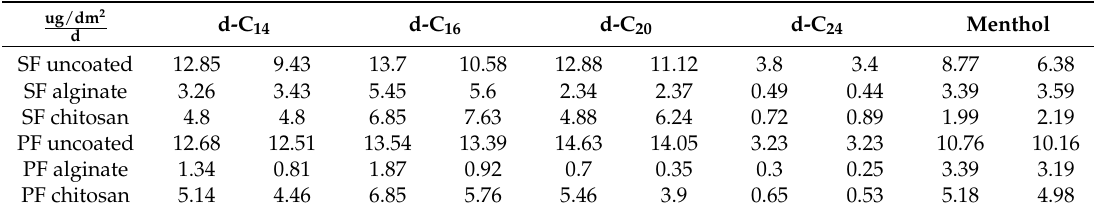
Table 6. Comparison of the permeation rates of deuterated n-alkanes of various chain lengths, and menthol through coated and uncoated paper samples from primary fiber (PF) and secondary